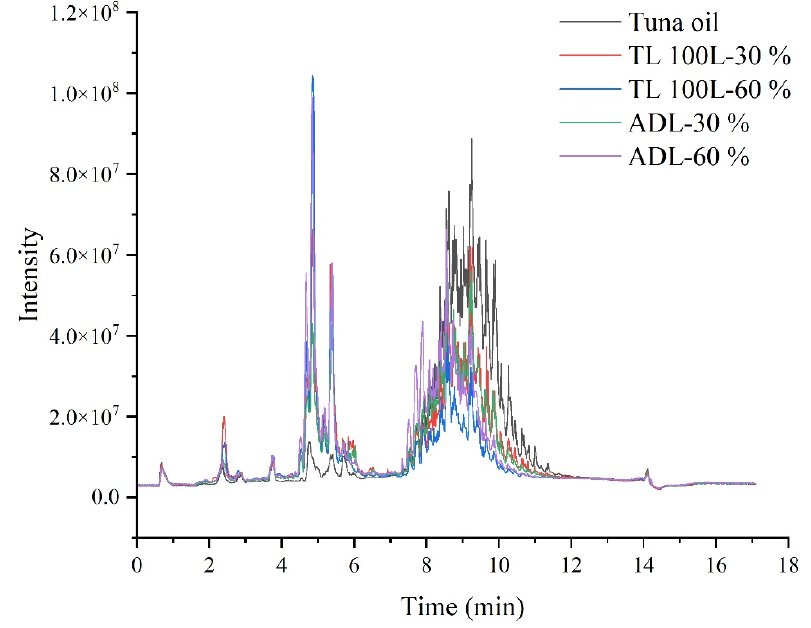
Figure A2. UPLC-Q-TOF-MS positive ion mode of five samples.